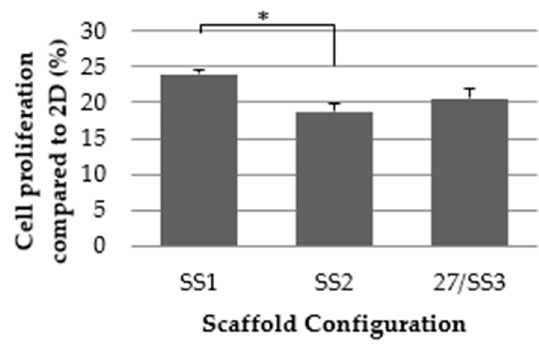
Figure 4. MDA-MB-231 cell proliferation assay of PLA scaffold configurations SS1, SS2 and 27/SS3 (3D) compared to two-dimensional surface (2D) ( n = 3). Significant differences are indicated as * ( p < 0.05).